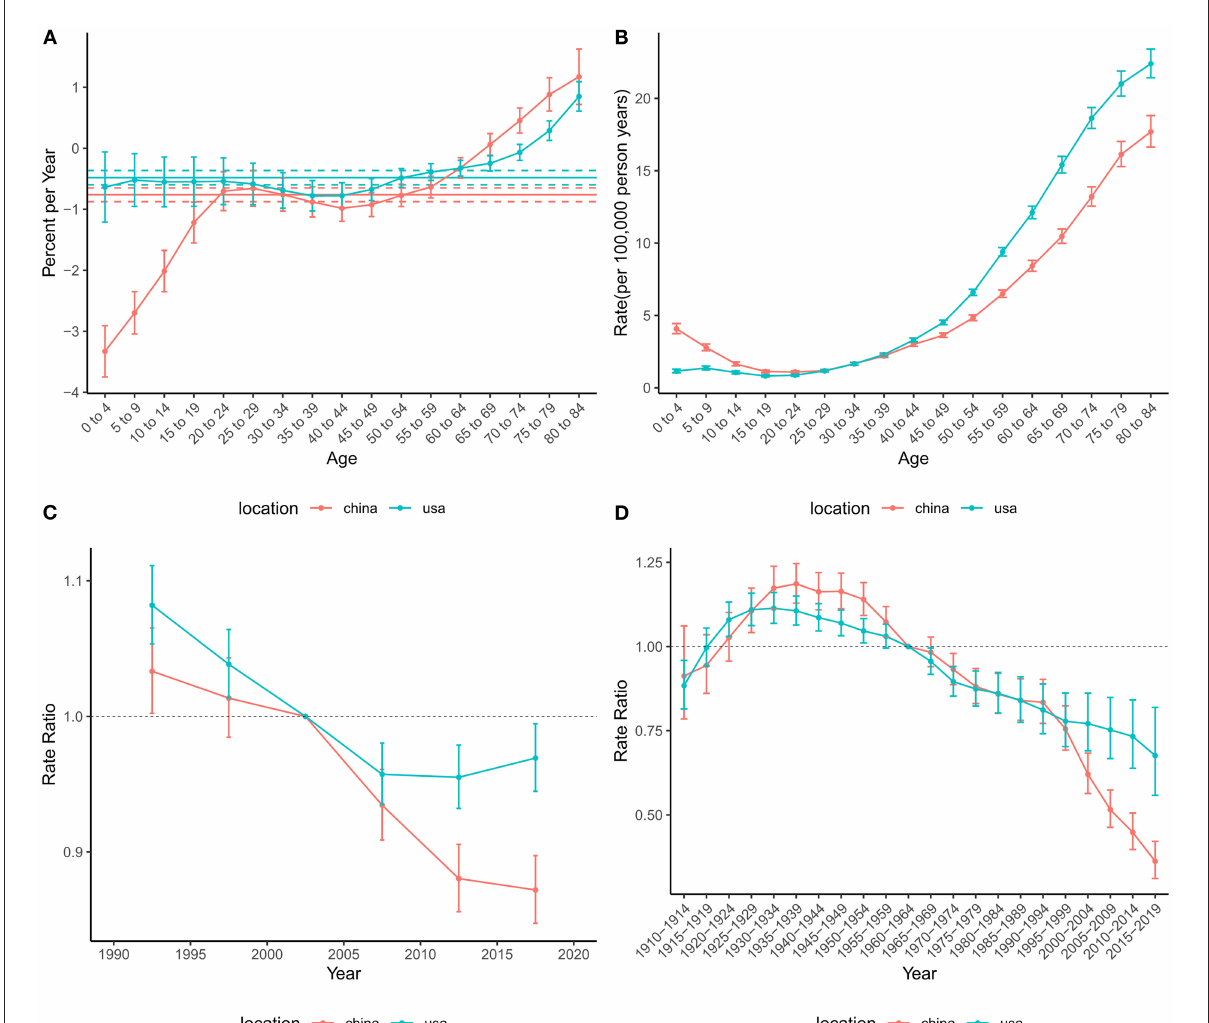
FIGURE4 Age-period-cohort effects on the mortality rate of brain and CNS cancers in China and the US. (A) Net drift and local drift values for brain and CNS cancers mortality rate in China and the US. (B) Longitudinal age curves for brain and CNS cancers mortality in China and the US. (C) Period effects on the brain and CNS cancers mortality rate in China and the US relative to the reference period (2000–2004). (D) Cohort effects on the brain and CNS cancers mortality rate in China and the US relative to the reference cohort (1960–1964). Vertical solid bars represent the 95% confidence intervals. CNS, central nervous